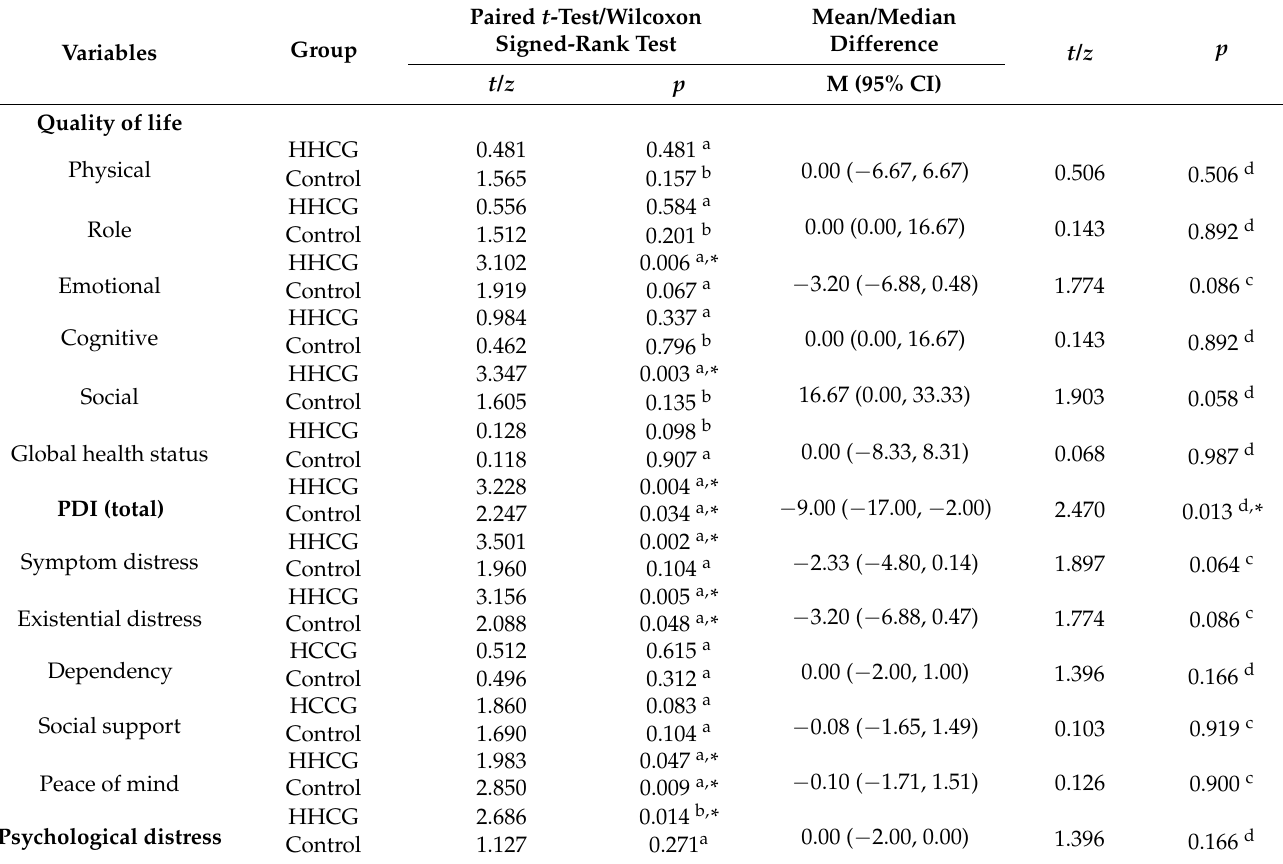
Table 4. Evaluation of Heart to Heart Card Games on quality of life, dignity, and psychological distress in the intervention and control group ( N =